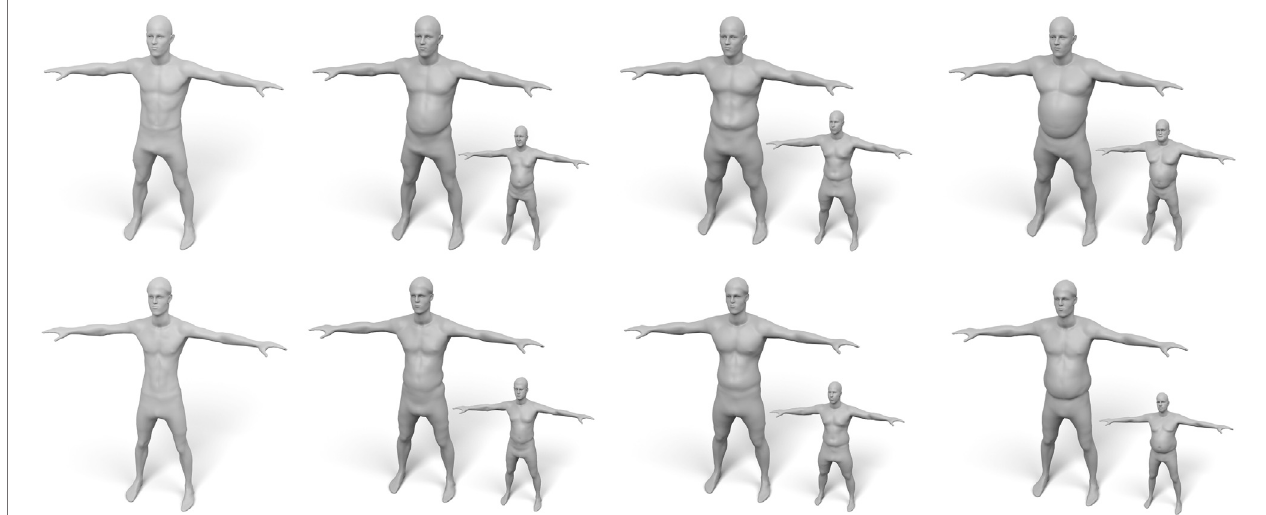
FIGURE 15 | Examples of “ fat transfer ” . The two subjects (top/bottom) on the left have a very low amount of body fat. Therefore, scaling their fat volumes is not suitable for fat growth. Instead, we copy the fat distributions of other subjects (shown as small insets) and transfer them to the skinny targets.